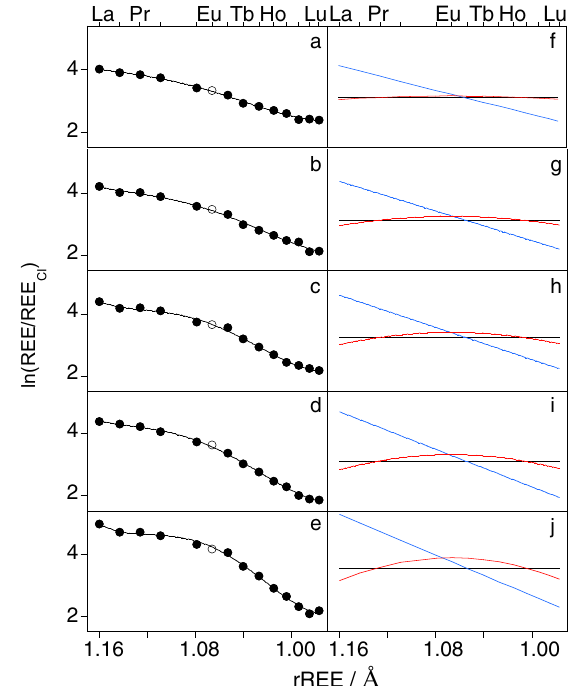
Fig. 1 Fits of the rare earth element (REE) patterns of the basanite- nephelinite suite to orthogonal polynomials. The chondrite normalised abundances of the REE (symbols) in a the least evolved glass (B11), b C13, c C18, d B20, and e the most evolved glass (C4), and the fi ts (Eq.1; black line) to the data resulting from the sum of the orthogonal polynomials shown in f – j where the value of the average REE abundance ( λ 0 ; black) has been added to the orthogonal polynomials for slope ( λ 1 f 1 ; blue) and curvature ( λ 2 f 2 ; red) for ease of plotting. Eu was not included in the fi ts and is indicated by an open symbol in ( a – e ).